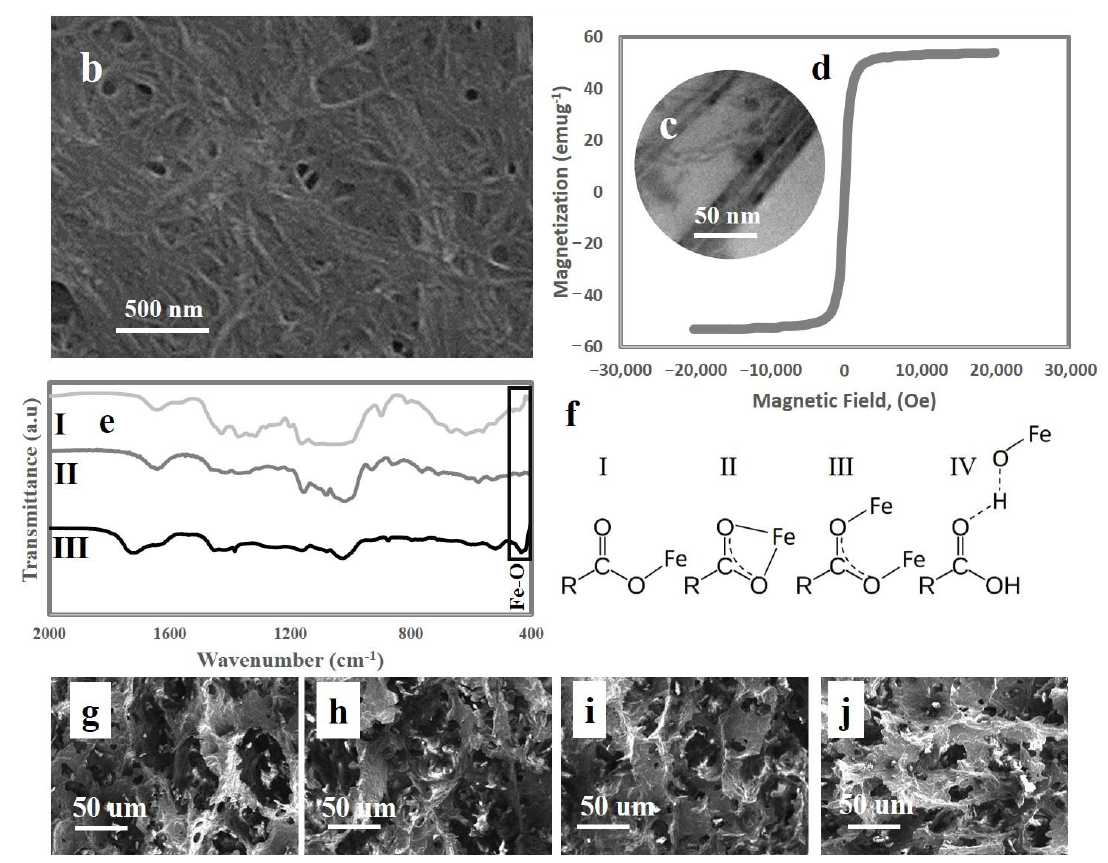
Figure 1. ( a ) Synthesis of magnetic nanochitin at a stoichiometric aqueous quantity of Fe(II)/Fe(III) salt solution and an alkaline solution in a non-oxidizing environment; ( b ) SEM photograph of na- nochitin; ( c ) TEM photograph of magnetic nanochitin; ( d ) magnetic hysteresis loop of magnetic na- nochitin at the temperature of 300 K ; ( e ) FTIR spectra of (I) magnetic nanochitin, (II) nanochitin, and (III) acrylic acid-g-starch/magnetic nanochitin ferrogel; ( f ) the possibility for interaction between iron oxide nanoparticles and polymeric chains; ( g ) SEM photographs of ferrogel containing 0.5 wt.% magnetic nanochitin; ( h ) SEM photographs of ferrogel containing 1 wt.% magnetic nanochitin; ( i ) SEM photographs of ferrogel containing 1.5 wt.% magnetic nanochitin; and ( j ) SEM photographs of ferrogel containing 2 wt.% magnetic nanochitin.